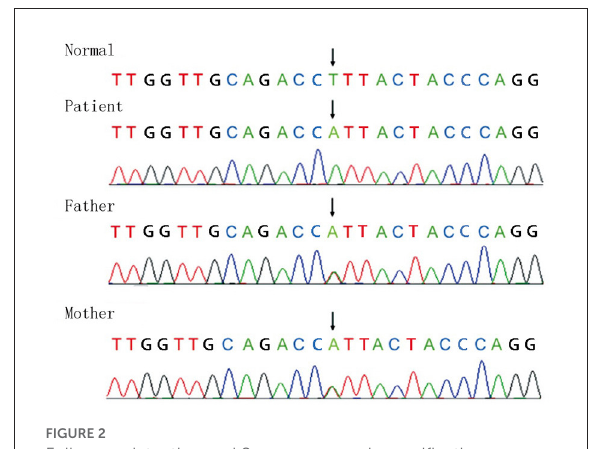
FIGURE2 Full-exon detection and Sanger sequencing verification were performed on the children and their parents C. 553T > A homozygous missense mutation (NM_ 001289790, F 185 I) was found in exon 6 of the GPI gene, which was inherited from the